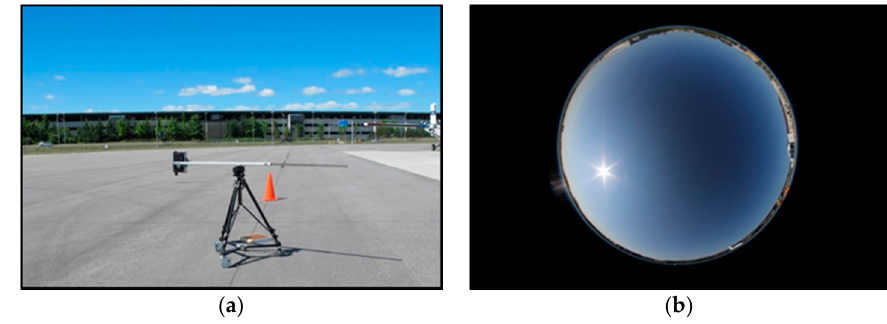
Figure 1. ( a ) Experimental setup for acquiring in-situ ground hyperspectral measurements of an asphalt target using the HR-1024i spectrometer. ( b ) The hemispherical sky photo was acquired simultaneously with the ground spectrometer measurements as a means of estimating the potential influence of cloud and visible aerosol (haze) during the time of data acquisition. All data were collected under stable conditions.